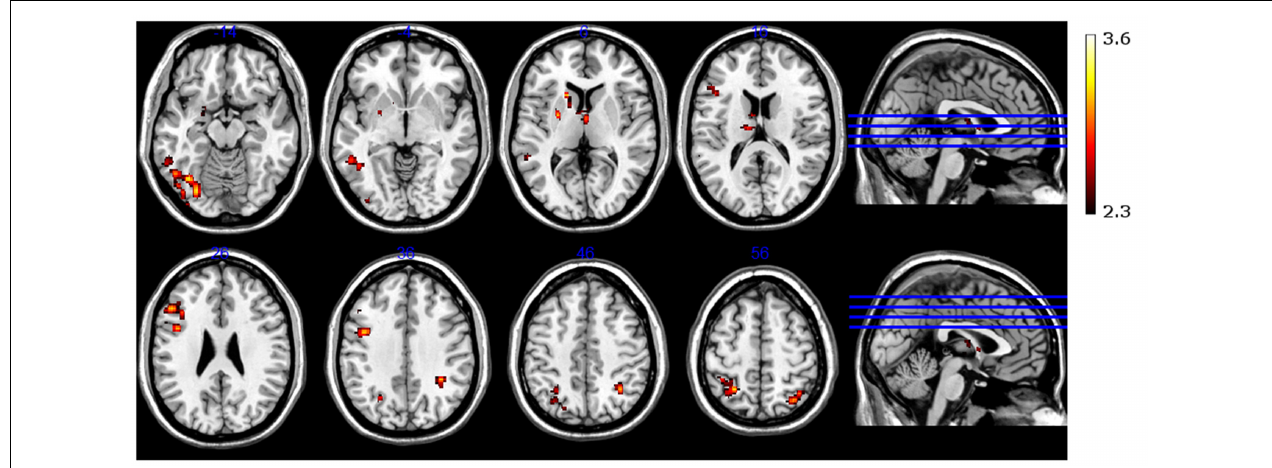
FIGURE 6 | Functional magnetic resonance imaging contrast for successfully encoded (later recognized) > unsuccessfully encoded (later forgotten) CRA solutions.